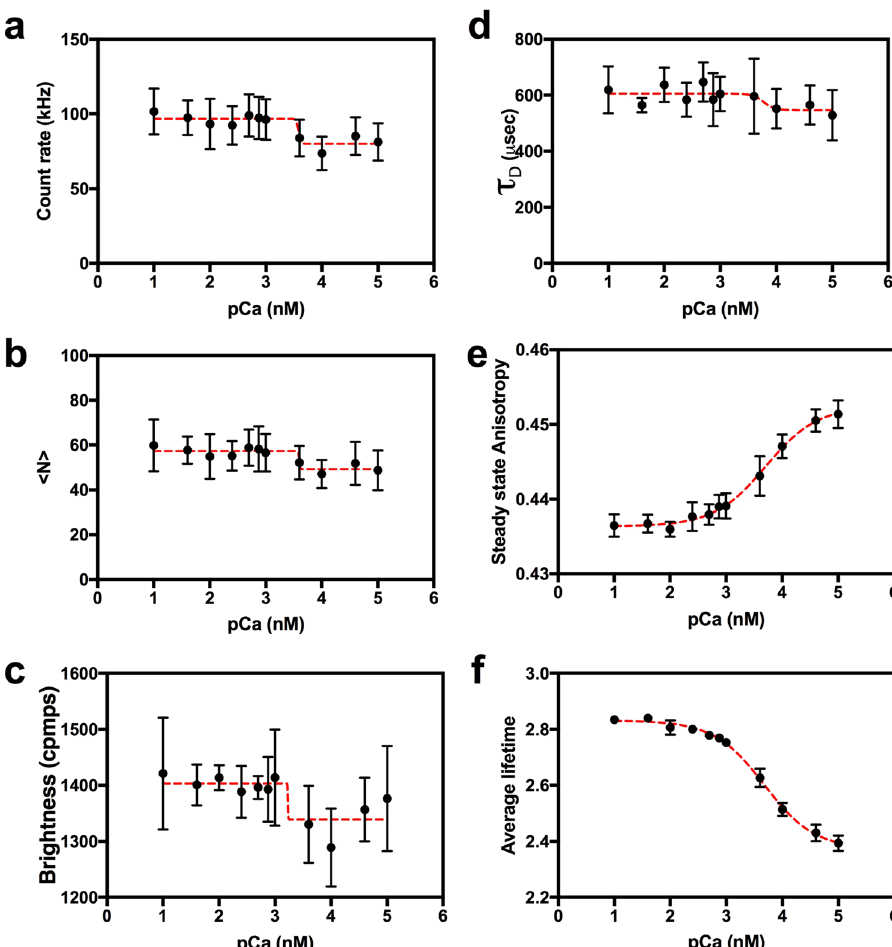
Figure 6. Auto-FPFA characterization of Venus-Twitch4-mCherry, a hetero-FRET based calcium biosensor. Auto-FPFA was used to measure count rate ( a ), < N > ( b ), brightness ( c ), diffusion time ( τ D , d ), steady state anisotropy ( e ), and average lifetime ( f ) of two different homogenates prepared from cells expressing Venus- Twitch4-mCherry. Homogenates were diluted into buffers with defined calcium concentrations where pCa indicates the log of the free calcium concentration in nano-moles. Each point is the mean ± SD (N = 4, two from each homogenate preparations). Dashed lines are a four parameter, variable slope dose-response